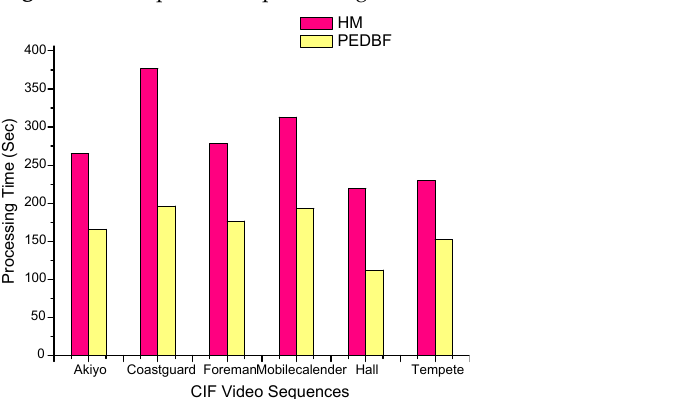
Figure 19. Comparison of processing time with HM for QCIF video sequences using QP = 32.